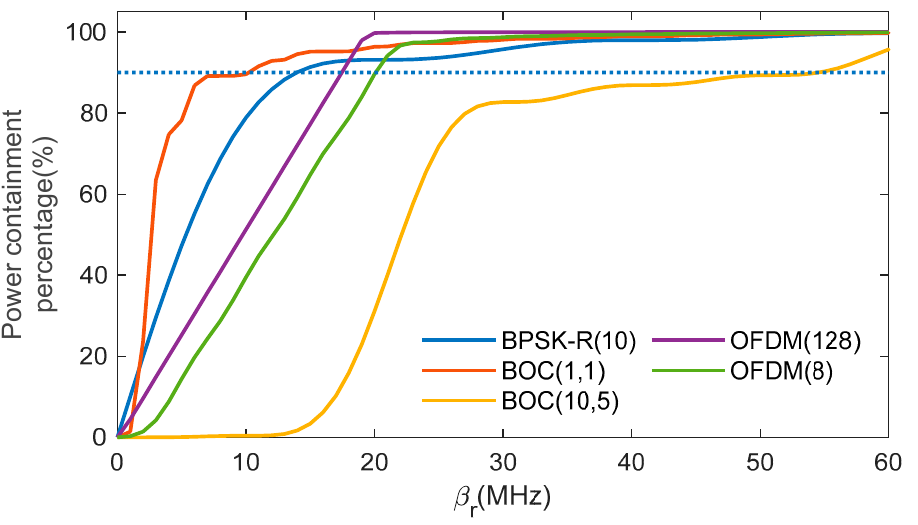
Figure 11. Relationship between the power ratio and bandwidth. The blue dash line is 90% power containment.